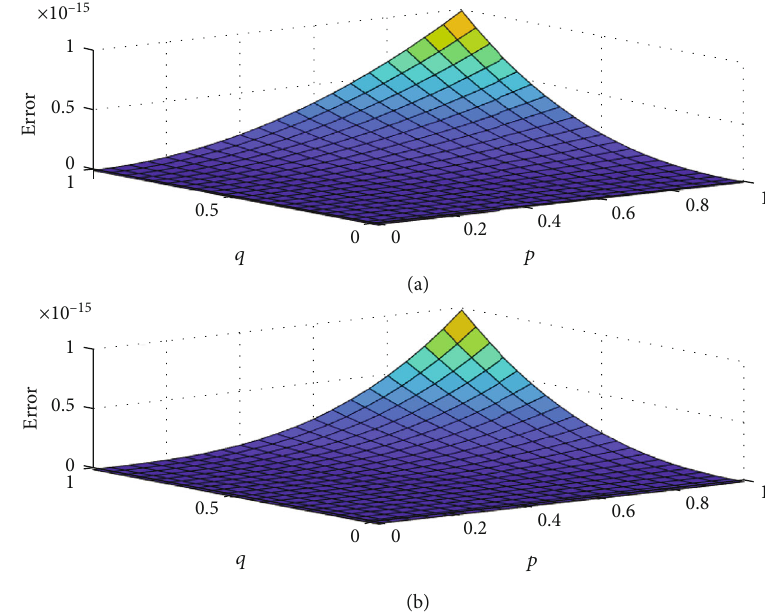
Figure 8: Charts of absolute error z (a) and v (b) with ρ = ω = υ = 1 for Example 10 when m = 6 .